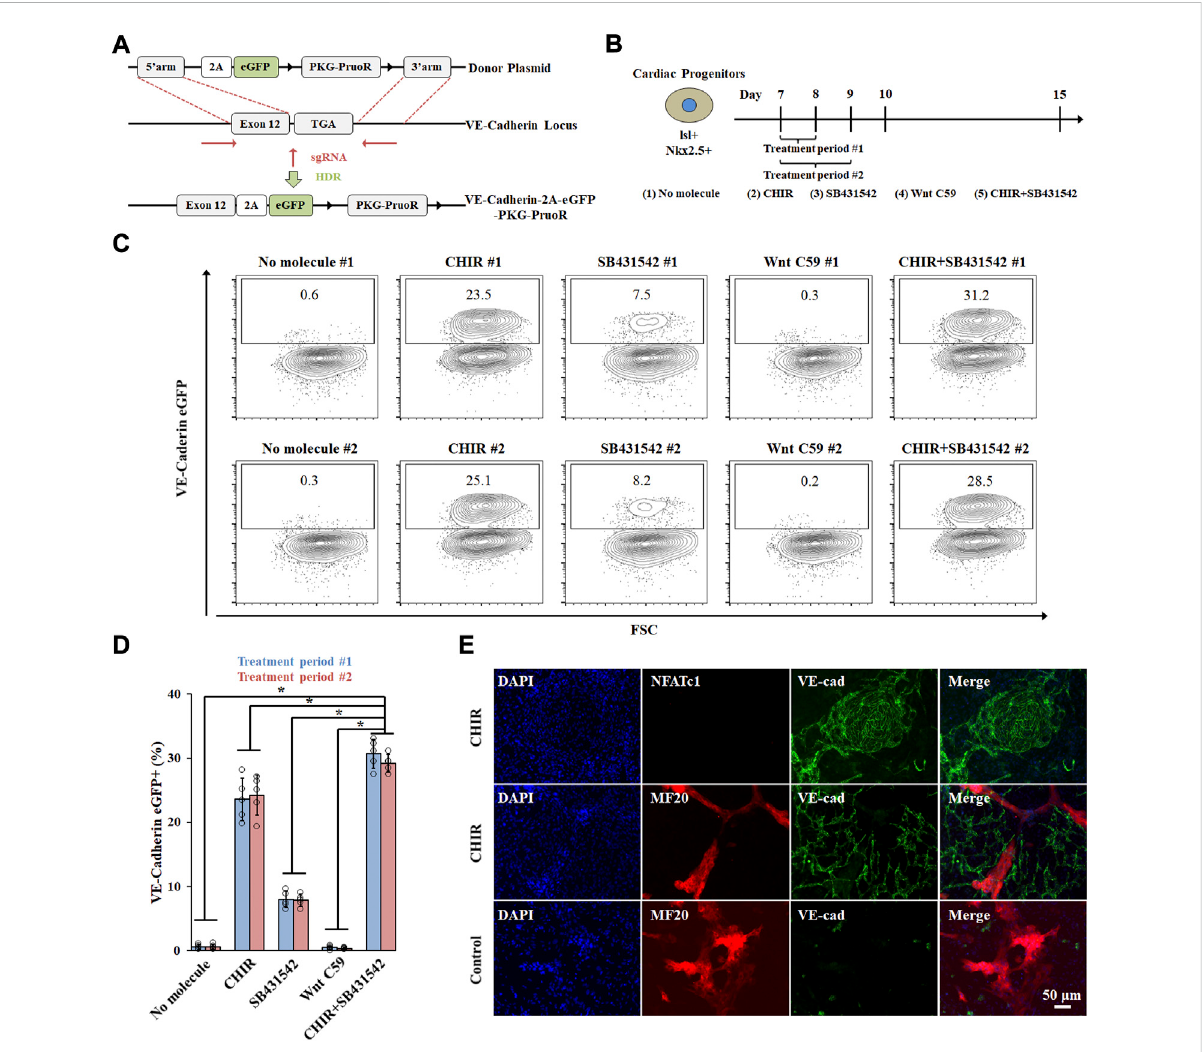
FIGURE 1 Cardiac endothelial cell generation by modulating Wnt signaling pathway. (A) Schematic illustration of knock-in strategy at the AAVS1 safe harbor locus. (B) Schematic of the protocol used to differentiate hPSCs towards cardiac endothelial cells. Conditions of 1 – 5 were applied